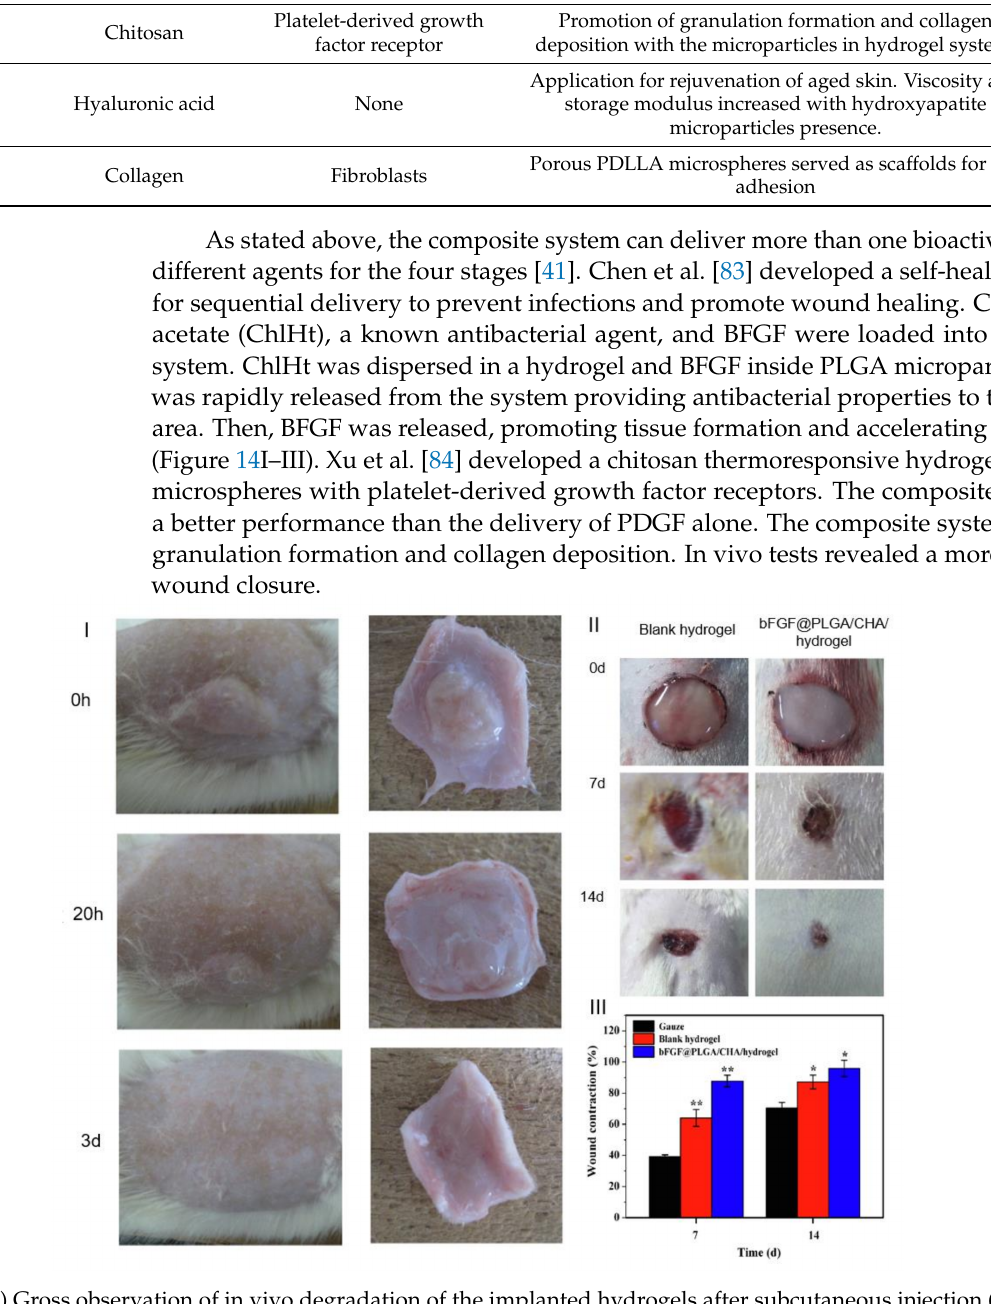
Figure 14. ( I ) Gross observation of in vivo degradation of the implanted hydrogels after subcutaneous injection (left) and the tissue surrounding the hydrogels extracted (right) from the rats, ( II ) gross observation of wound contraction of blank hydrogel (left) and loaded composite (left), ( III ) percentage of wound contraction. * p < 0.05, ** p < 0.01 compared with the gauze group. (Adapted with permission from [83]. Copyright (2019)